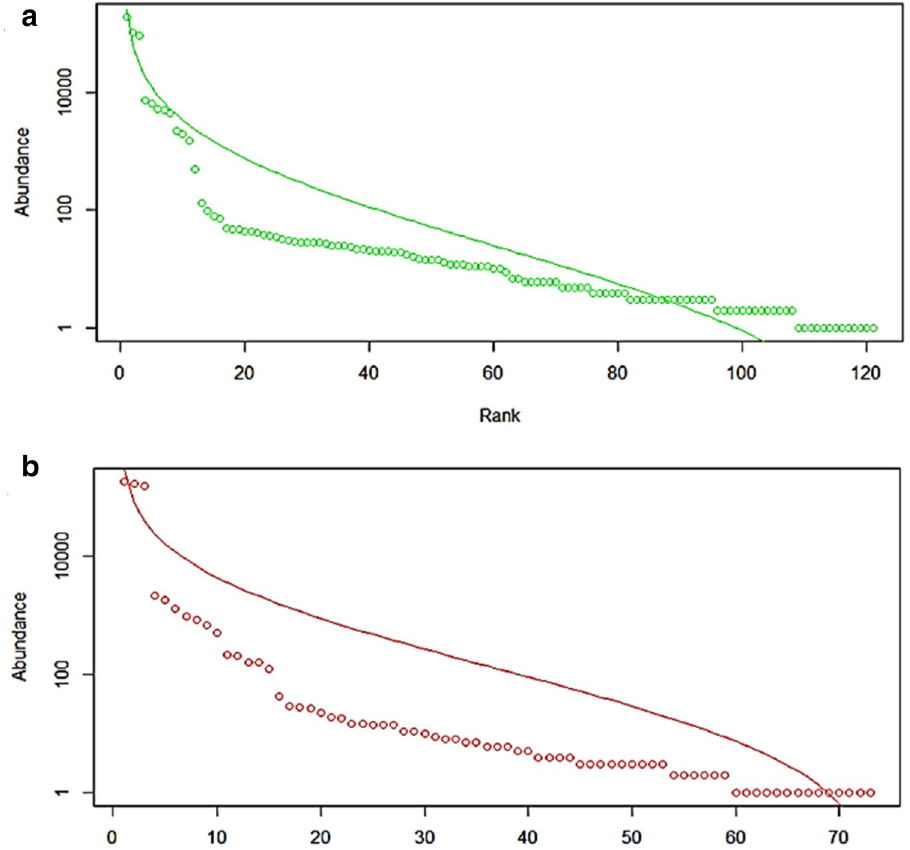
Figure 2. The rank-log abundance graphs of sponge metagenome samples. The conformity to the geometric series distribution of two sponge species namely is showed in ( a ) Gelliodes pumila and ( b ) Cliona